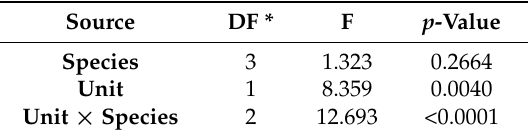
Table 8. Two-way ANOVA for combined data from units CR 1200 and CR 1003 showing degree of freedom, F statistics, and p -value for main effects (unit and species), and their interaction with scar width (dependent